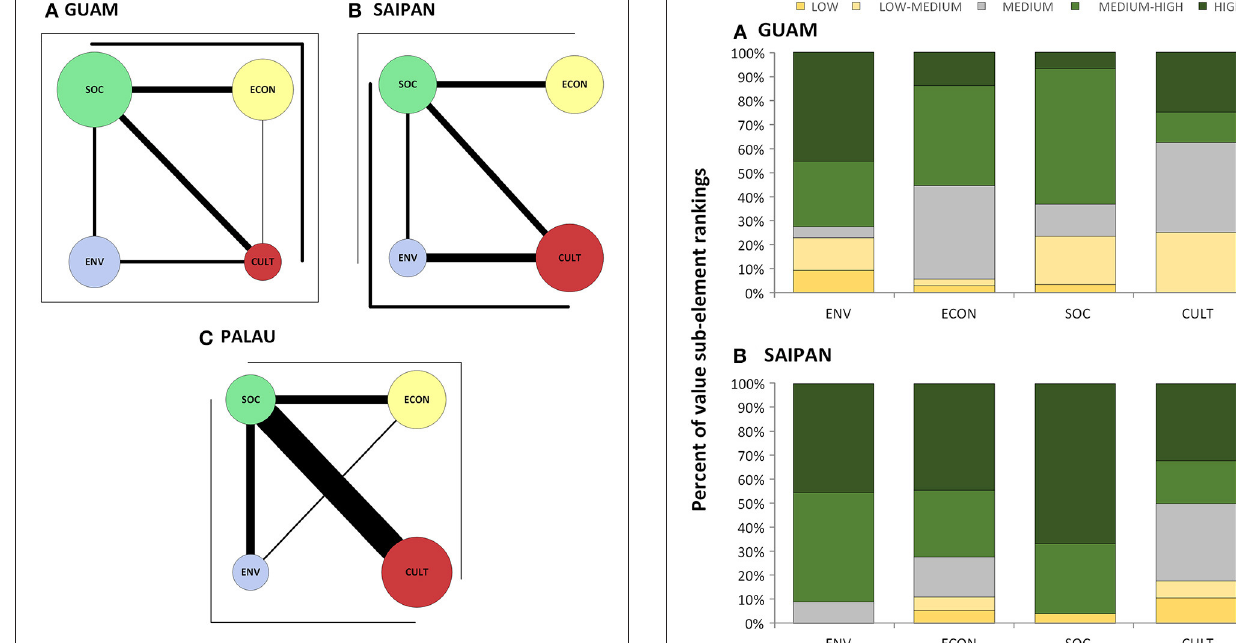
FIGURE 3 | Value networks illustrating the proportion of core values for each country and the strength of linkages between core values for: (A) Guam; (B) Saipan; and (C) Palau. Core values are denoted by SOC, social; ECON, economic; ENV, environmental; and CULT, cultural. The number of identified sub-elements in each category (one, two, three, four core values) is represented graphically by the size of the nodes or thickness of the edges (networks). Note that edges connecting three or four nodes are depicted by the outside (unconnected) lines.